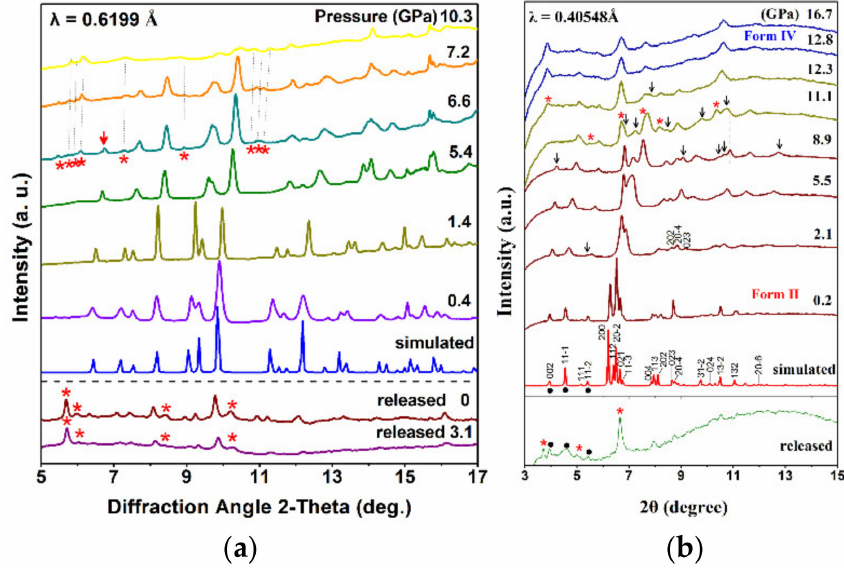
Figure 8. ( a ) Representative high-pressure ADXRD patterns of CA form-I. Red asterisks indicate new peaks. Down arrow indicates the disappearing diffraction peak. Reprinted with permission from Ref. [95]. Copyright 2019 Institute of Physics ( b ) Representative high-pressure ADXRD patterns of CA form-II. Red asterisks represent the peaks of form IV. Black dots show the peaks of form II. Down arrows show the disappearing diffraction peaks of form II. Reprinted with permission from Ref. [96]. Copyright 2021 American Chemical